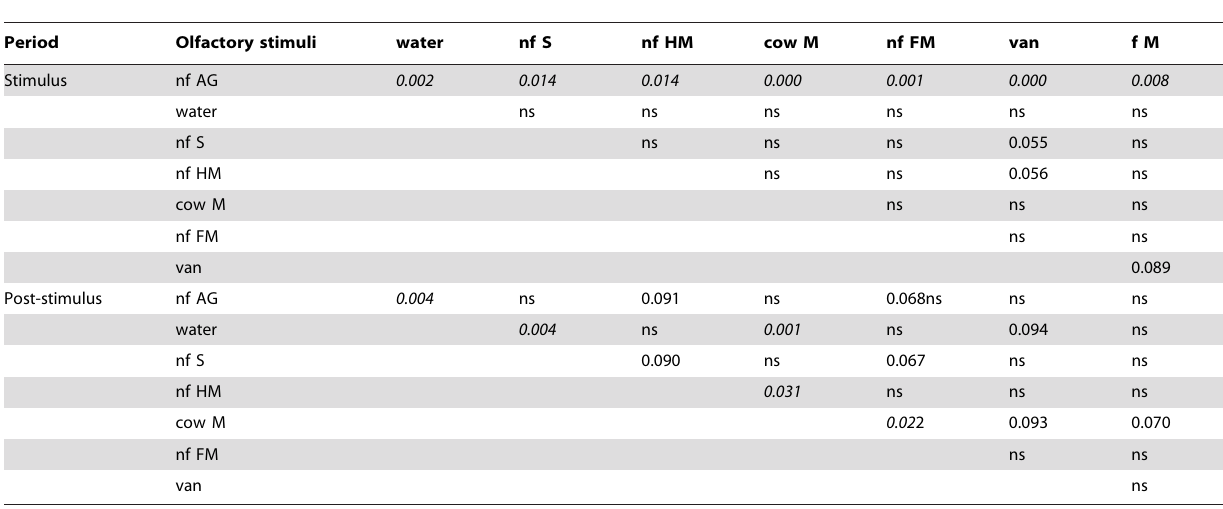
Table 1. Interactions between odor stimulus and test period for infant behavior.